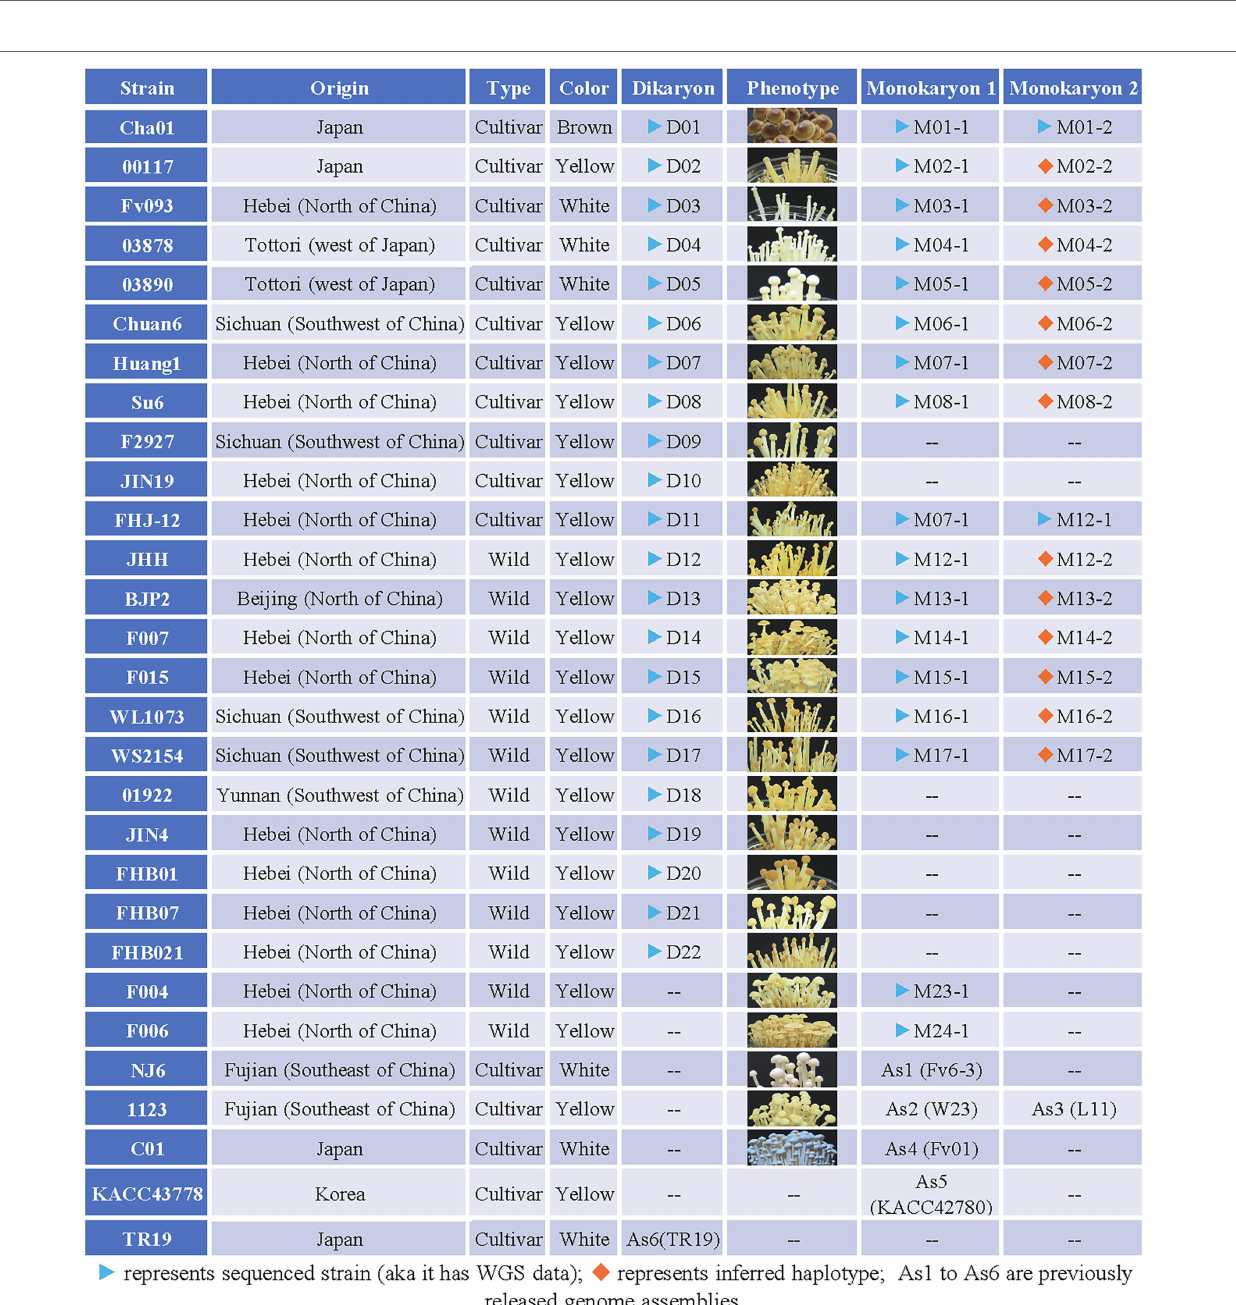
FIGURE 1 | Collection of Flammulina filiformis strains information table. “Origin” represent the origin of the strain; “Type” represent the strain is wild type or cultivated type, wild type refers to strains collected in the field, while cultivated type refers to commercially available strains used for commercial production; “Color” represent the fruiting body of F. filiformis strain; “Dikaryon” and “Monokaryon” represent the Dikaryon strain and its associated two mononuclear strains; “Phenotype” represent the phenotype at the stage of the fruiting body of the